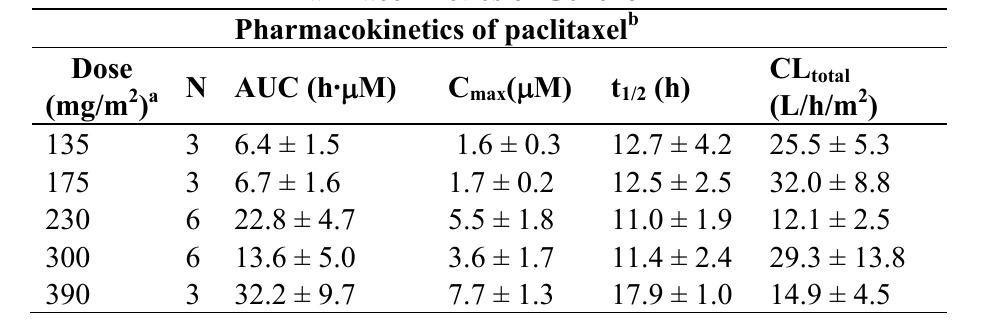
Table 8. Results of Phase I pharmacokinetic study and toxicity of Genexol-PM in cancer patients [26]. Pharmacokinetics of Genexol-PM